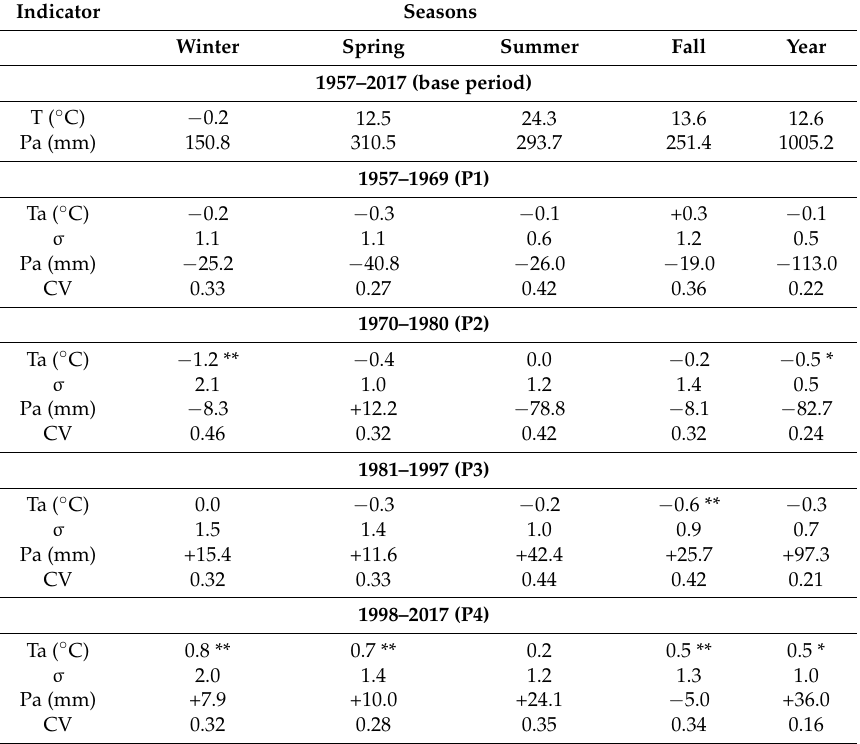
Table 3. As in Table 2, except for the Columbia, MO station in the USA. Statistically significant values with respect to the base period are marked with a * at the 90% level, and ** at the 95% level. Indicator Seasons Winter Spring